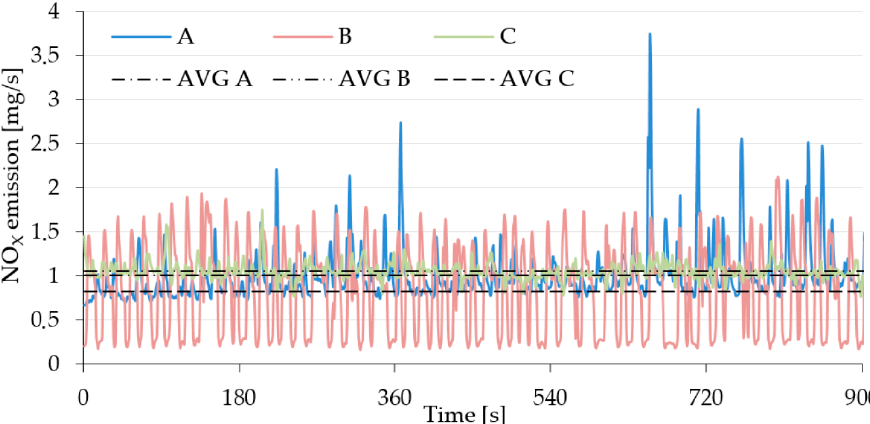
Figure 6. NO x emission as a time function during the chipping process: A: Carburettor fuel supply system; B: Injector fuel supply system; C: Injector fuel supply system equipped with an adaptive drive control system.